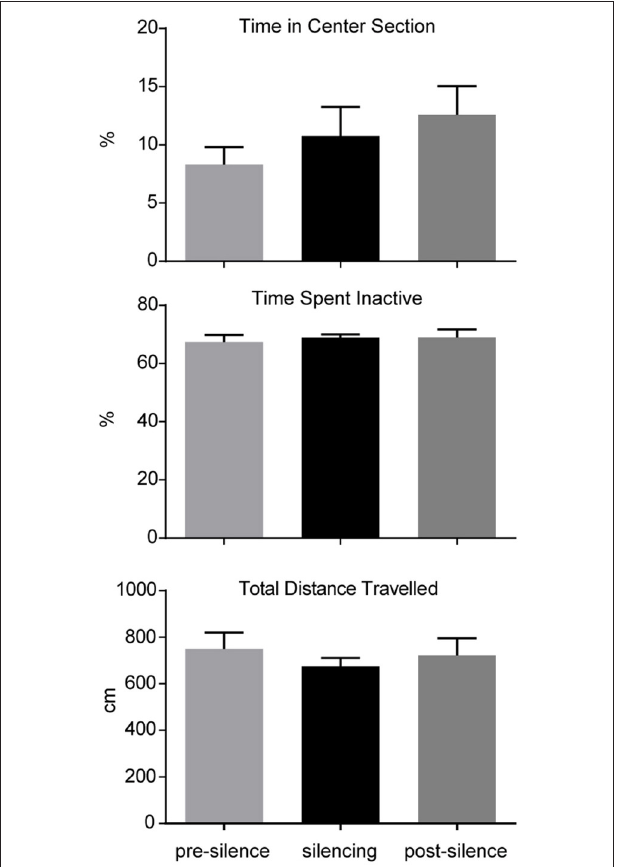
FIGURE 3 | Analysis of open field behavior during 1min pre-silencing, silencing and post silencing for OF3. The time spent in the center, time spent inactive and total distance traveled are not significantly affected by LC silencing. No significant difference exists between pre- and post-silencing periods that might potentially reflect a rebound of activity after